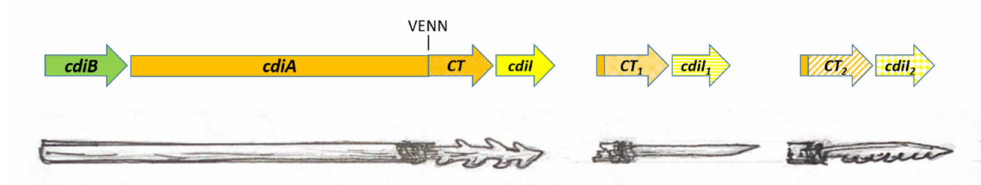
Figure 4. Orphan toxin / immunity modules. Orphan cdiA-CT / cdiI modules include conserved sequences upstream of the VENN-encoding region. Presumably, homologous recombination can occur with a full-size cdiA gene, so the orphan modules can be considered as a set of toxins “tips” for the protein